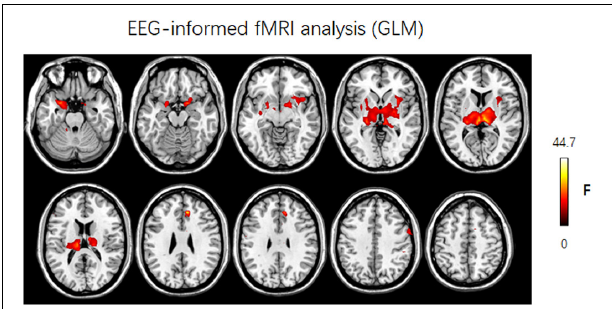
FIGURE 9 | Results of discharge-related hemodynamic changes in JME patients revealed by traditional EEG-informed fMRI analysis (GLM2, P < 0.005, uncorrected). F, F -value; Left is